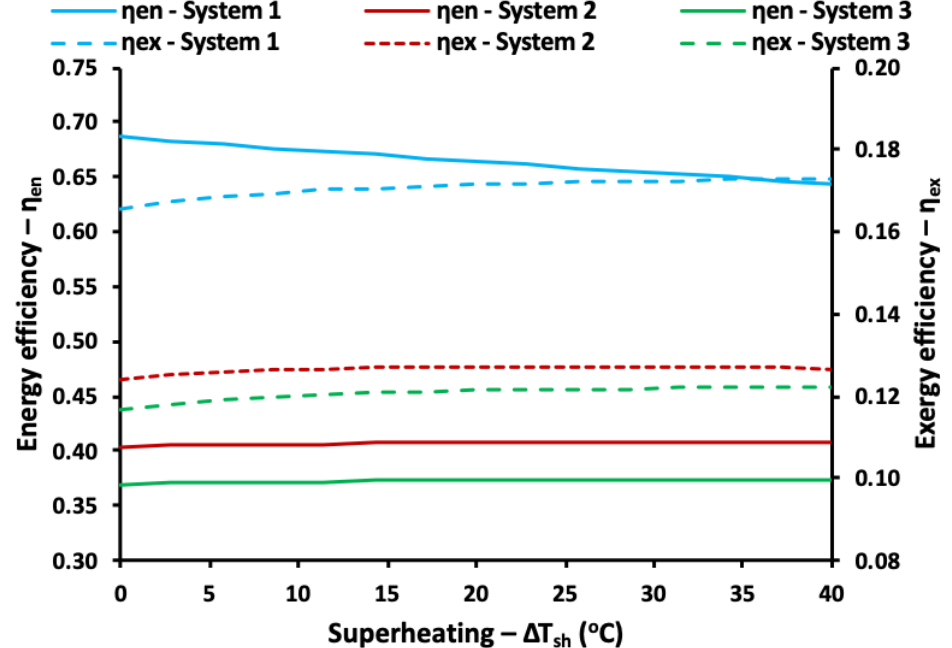
Figure 5. Energy and exergy efficiency for the three systems with different values of the superheating in the turbine inlet.